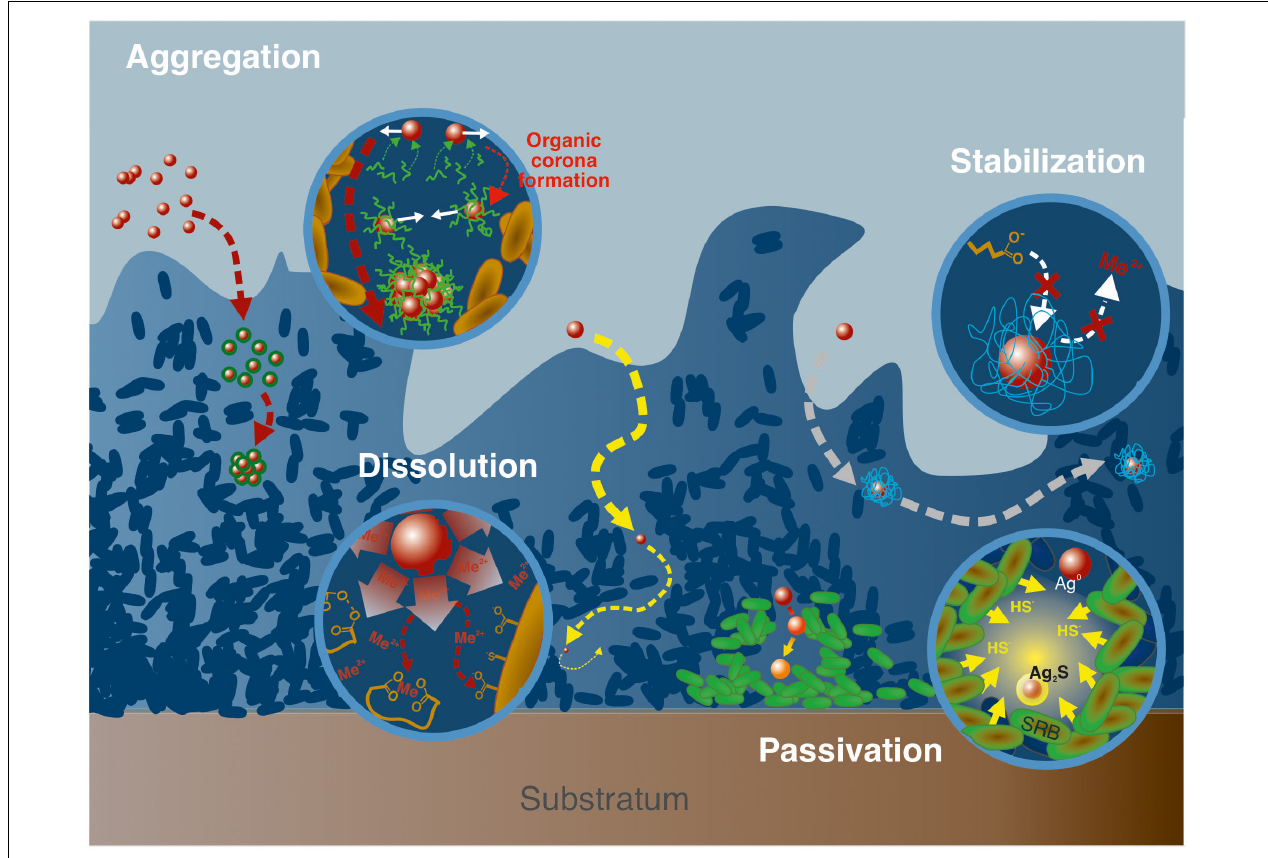
FIGURE 3 | Examples of processes associated to ENPs transformations and aggregation. From left to right, aggregation mediated by the formation, in the biofilm matrix, of an organic corona, that modifies ENPs surface properties and promotes interactions between ENPs; ligand-mediated dissolution involving the presence of highly complexing ligands (such as siderophores) that complex free metals in solution and thus promotes ENPs dissolution; passivation of silver NPs in vicinity of sulfato-reducing bacteria (SRB) that increase locally HS- concentrations, and favors sulfidation processes at the ENPs surface; ENPs stabilization through the formation of an organic corona that isolates ENPs from the surrounding solution thus limiting dissolution